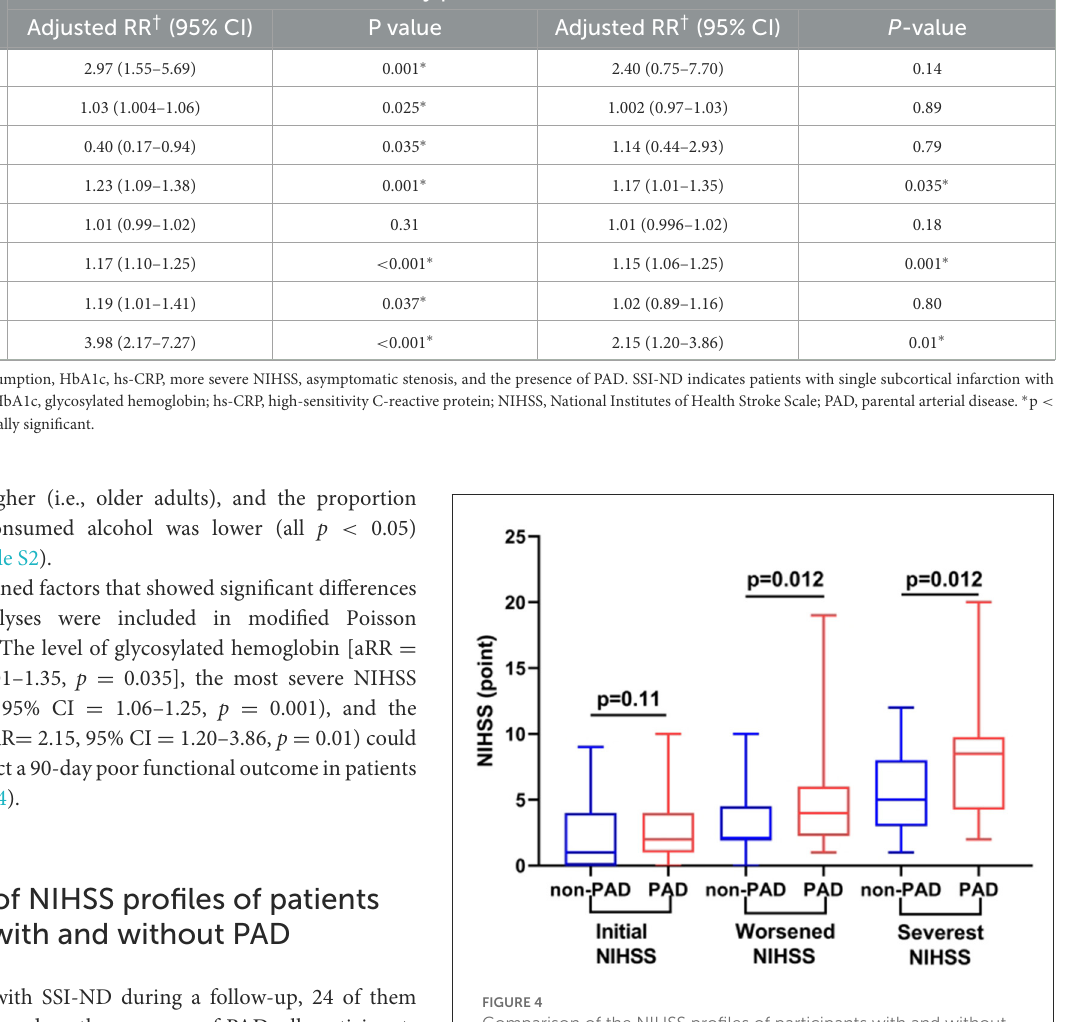
TABLE 4 Independent predictors of a 90-day poor functional outcome in patients with SSI-ND. Clinical factors